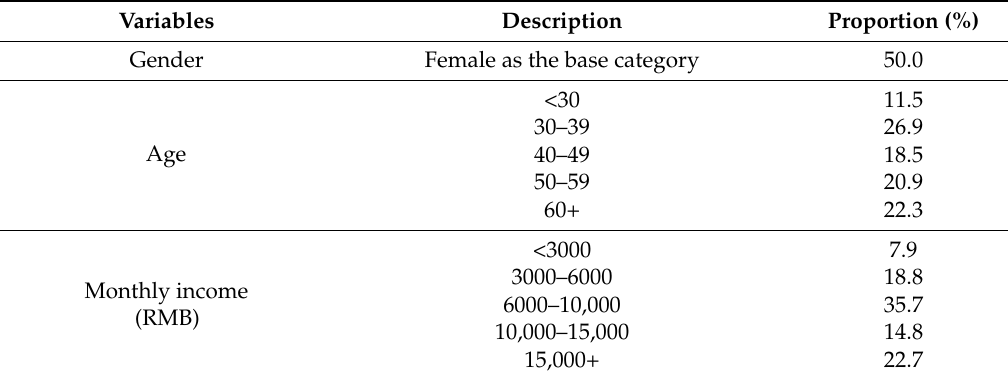
Table 1. Key socio-demographics and community environment evaluation in the